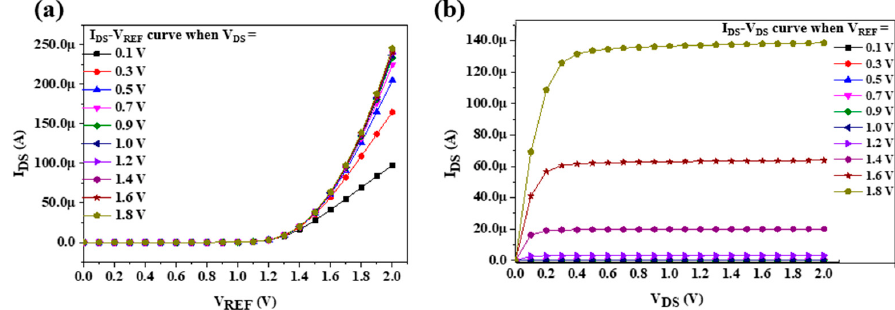
Figure 8. Transmission characteristics of commercial EGFET at different stationary voltages. ( a ) I DS - V REF transfer curve; ( b ) I DS –V DS transfer curve.